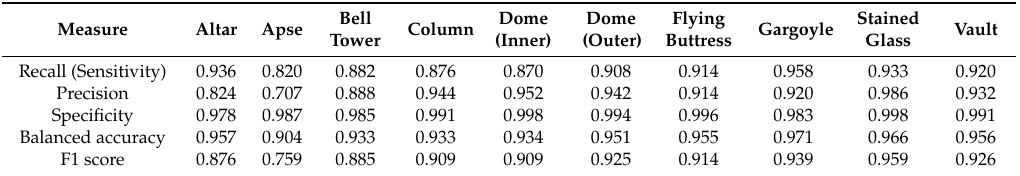
Table 11. Examples of best predictions using the ResNet network.